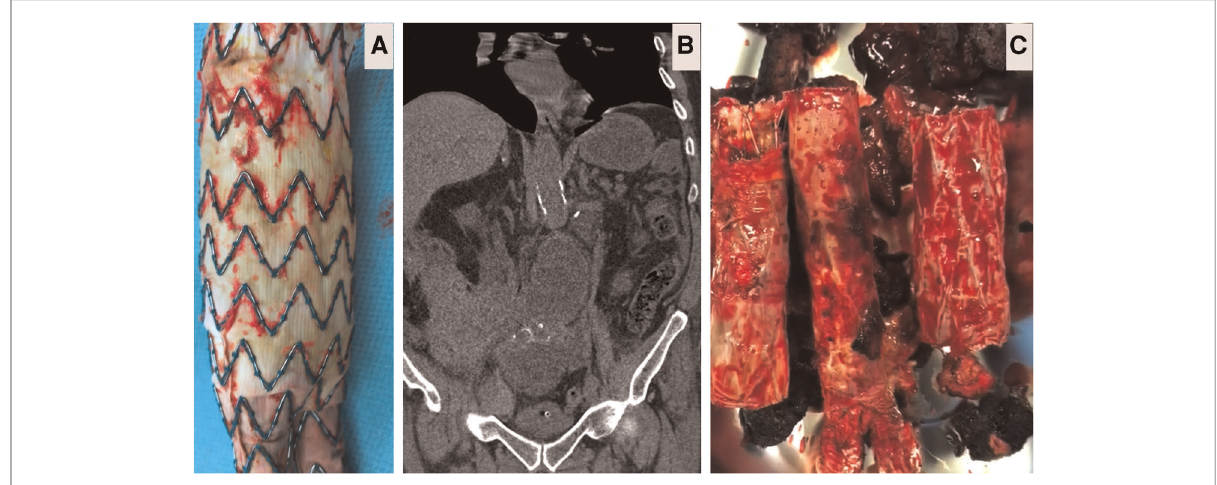
FIGURE 2 Explantation. ( A ) Body of partially explanted Cook (Bloomington, IN, USA) polyester-based endograft depicting micro-fabric pores due to chronic fatigue failure close to the allies of the stent. ( B ) Computed tomography angiography (CTA) image showing partially explanted Cook graft with the suprarenal spare springs and hooks left in-situ. ( C ) Here, patient underwent primary endovascular aneurysm repair (EVAR) with Endologix AFX (Endologix, Irvine, CA). However, this polytetra fl uoroethylene (PTFE) based endograft failed due to the fracture of the endoskeleton, which acted as a hinge against the PTFE. Attempts to salvage the EVAR resulted in implantation of two proximal cuffs over six years follow-up. The patient presented with rapidly expanding 8 cm abdominal aortic aneurysm and abdominal pain, necessitating immediate total graft explantation and aorto-bi-iliac reconstruction by 16×8 mm silver Dacron graft (Maquet, Rastatt,